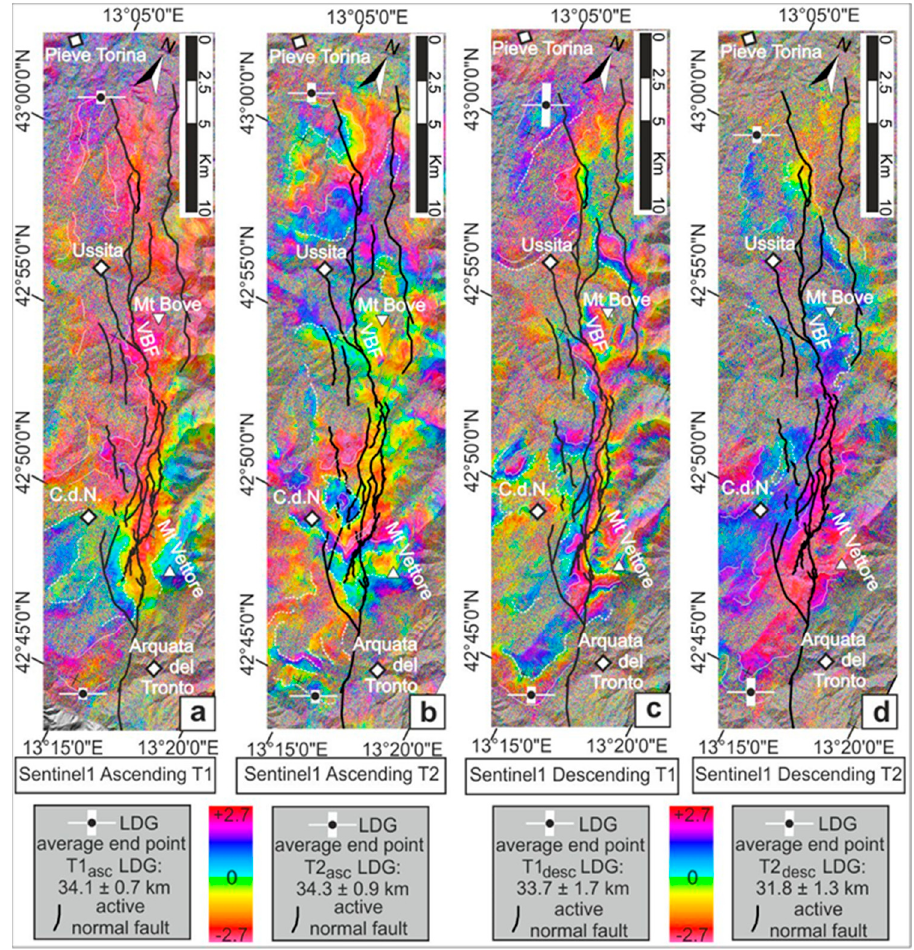
Figure 3. Phase changes detected before the occurrence of the Mw 5.9 foreshock during periods T1 (left) and T2 (right) as defined in text and Table 1. Interferograms were prepared using ESA Sentinel-1 images taken along relative ascending orbit 117 ( a , b ) and relative descending orbit 22 ( c , d ). We traced the interferometric fringes (white dotted lines) whose continuity is interrupted by low-coherence areas. The black dots mark endpoints of the segment delimiting the Length of Deforming Ground (LDG), and the corresponding white tapes show estimates of the endpoint location errors. One cycle of colors corresponds to one interferometric fringe (thicker white dotted lines) ~2.8 cm along the satellite Line of Sight (LoS). The thick black lines show the traces of the VBF. The colors show the patterns of phase changes around the VBF during the two intra-sequence periods, T1 and T2. C. d. N. = Castelluccio di Norcia.